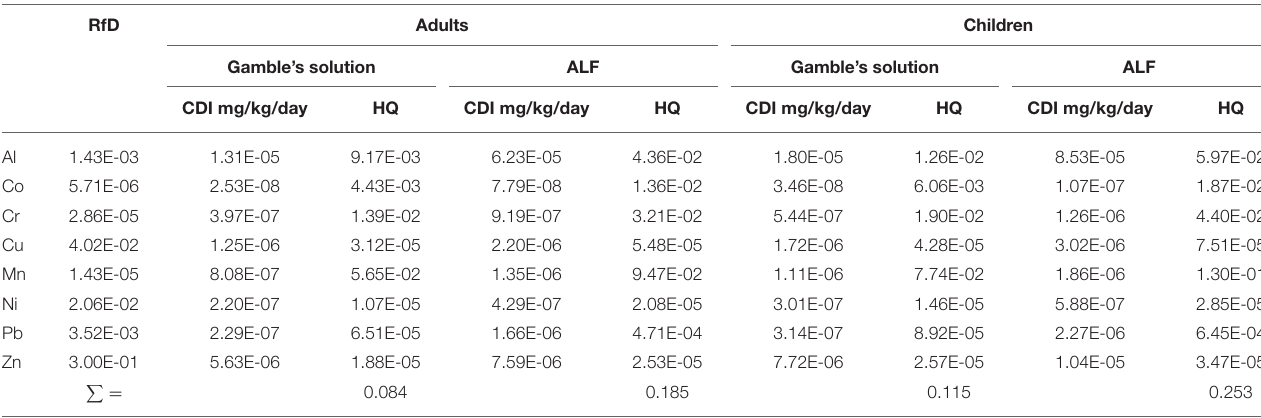
TABLE 4 | Chronic toxic risk (HQ) estimated for adults and